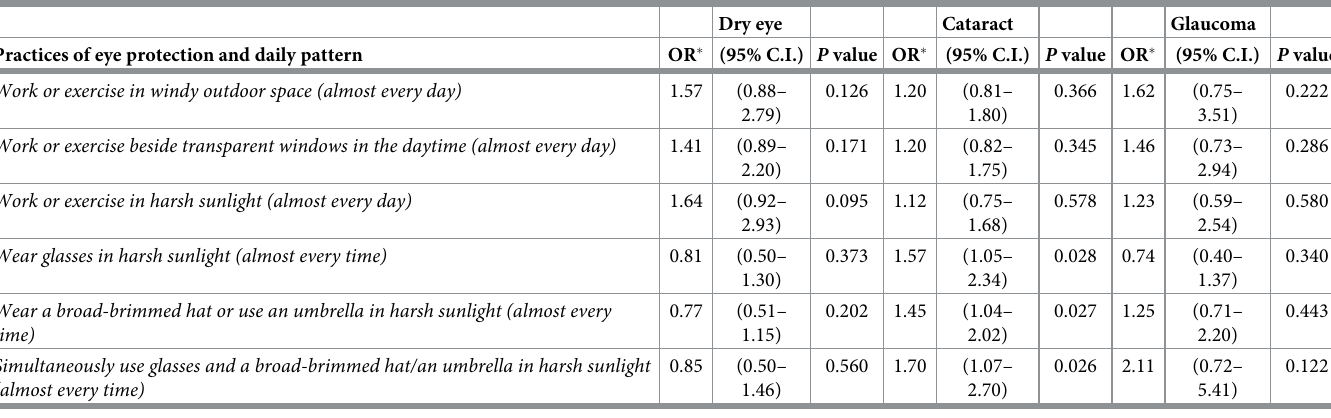
Table 4. Relationship between practices of eye protection under sun exposure and eye